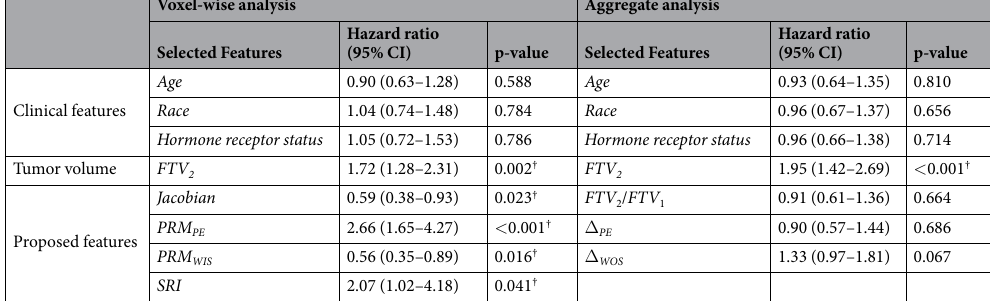
Table 3. Statistical analysis of voxel-wise versus aggregate features in multivariable RFS models. † p <